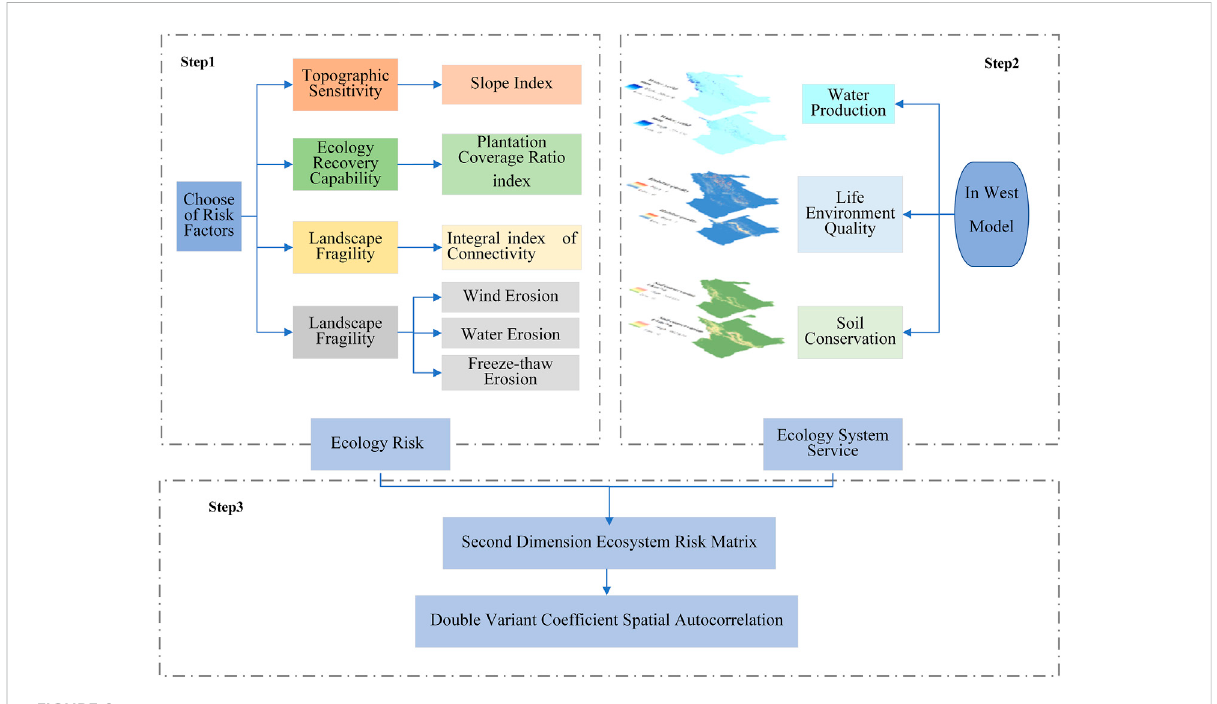
FIGURE 2 Evaluation frameworks for ecological risks and ecosystem